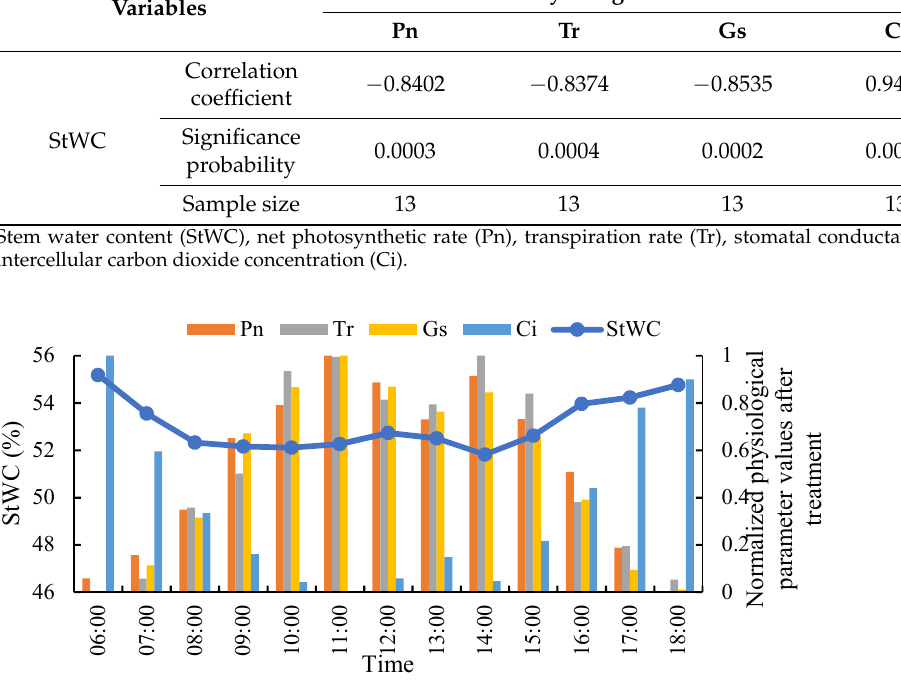
Figure 3. Diurnal variation rules of StWC and environmental parameters Pn, Tr, Gs, and Ci of Lagerstroemia indica L. under unstressed conditions on a typical day in summer, the results of Pn, Tr, Gs, and Ci were normalized to facilitate the observation of correlation patterns.